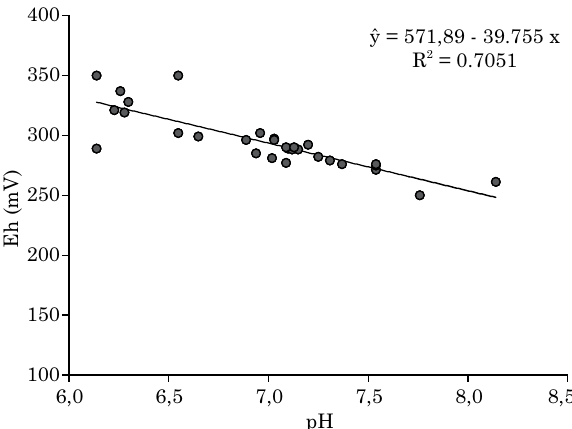
Figure 3. Correlation between Eh and pH in the field of the seven pedons from mangrove soils in the Subaé river basin, Santo Amaro, Bahia,